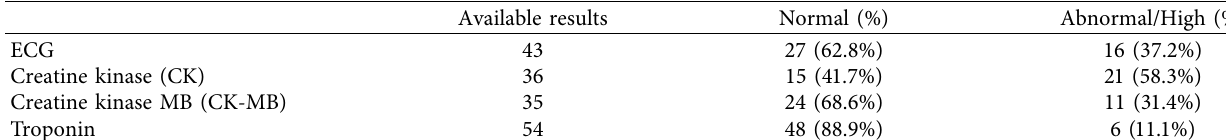
Table 6: ECG and cardiac enzyme levels in admitted patients with sternal fractures.